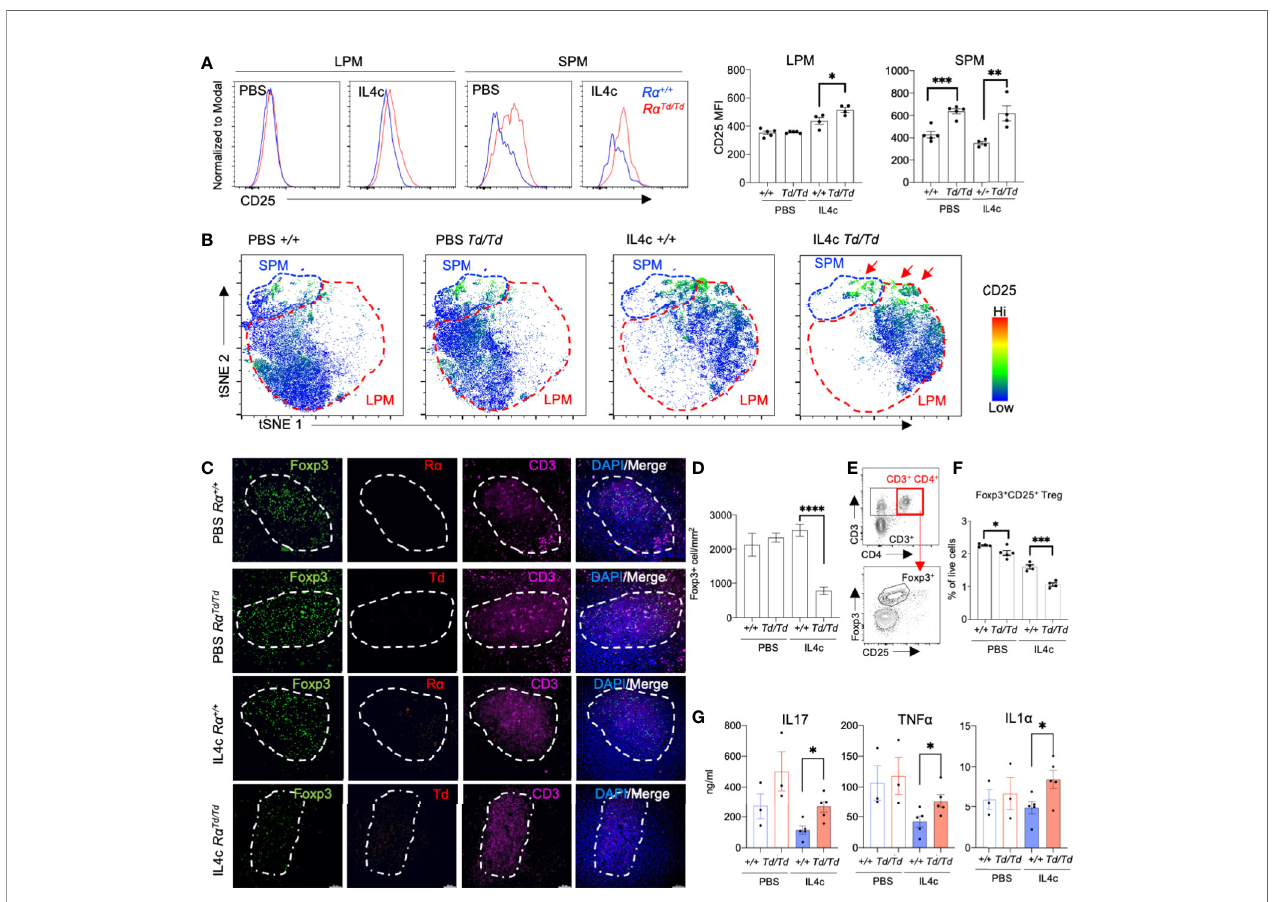
FIGURE 6 | Impaired splenic regulatory T cell responses in RELM a -de fi cient mice are associated with increased in fl ammatory cytokines. Peritoneal cells and spleens from R a +/+ or R a Td/Td mice treated with PBS or IL-4c were recovered for evaluation of macrophage and T cell responses. (A) CD25 expression in SPM and LPM. (B) t-SNE -guided gating of peritoneal cavity LPM and SPM and analysis of CD25. (C, D) Immuno fl uorescent staining for CD3, Foxp3, RELM a and Td was performed on spleen sections and Foxp3+ cells were quanti fi ed. Bar: 50 m m. (E) Gating strategy for effector and regulatory splenic T cells. (F) Frequency of Tregs in spleen evaluated ex vivo by intracellular staining for Foxp3. (G) Cytokine secretion was quanti fi ed from splenocytes stimulated with a CD3/ a CD28 for 72 hours. *, p ≤ 0.05; **, p ≤ 0.01; ***, p ≤ 0.001; ****, p <